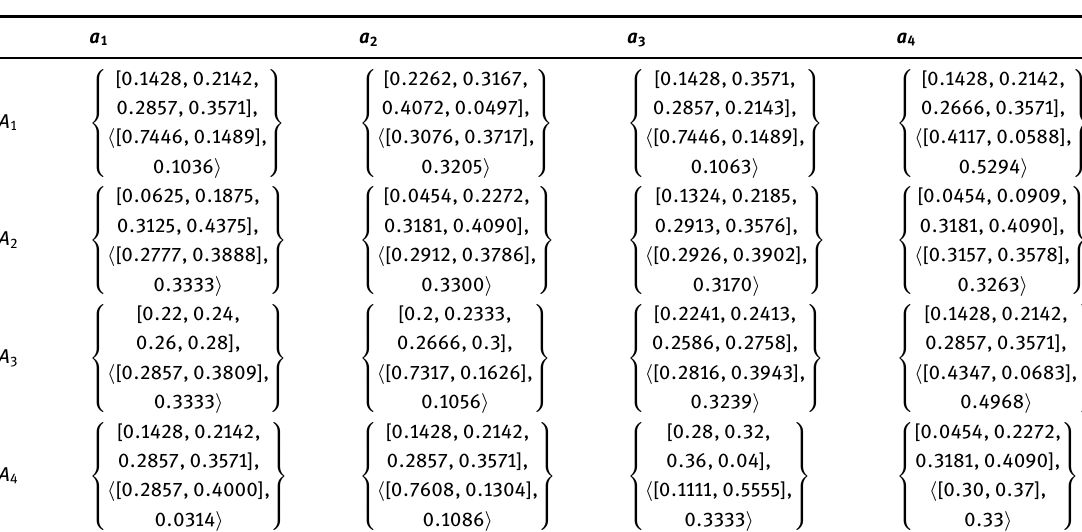
Table 4: Normalized Decision Matrix Given by Expert p 1